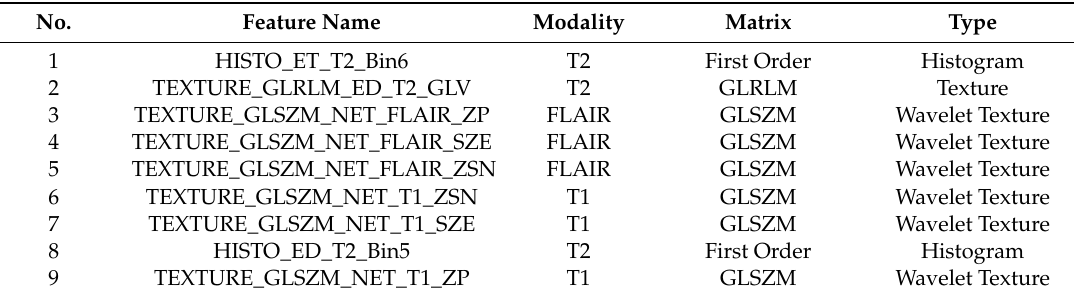
Figure 1. Recursive feature elimination (RFE) curve for predicting O6-Methylguanine-DNA methyltransferase (MGMT) methylation status in patients with IDH1 wildtype glioblastomas (GBM) by using different features. Nine features were used as optimal cutoff points. Table 2. Top nine radiomics features in our model.